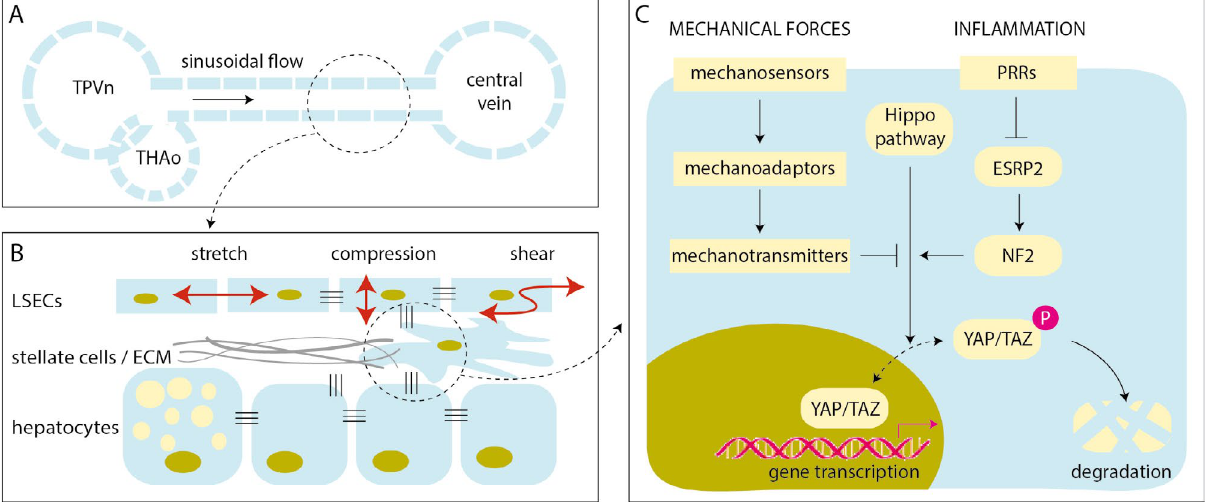
Figure 1. Mechanotransduction and the regulation of YAP/TAZ in NAFLD. A. Schematic illustration of a liver sinusoid with blood flowing from the confluence of terminal portal venule (TPVn) and terminal hepatic arteriole (THAo) toward the central vein; B. LSECs are subjected to various forms of mechanical forces by the blood flow (red arrows). LSECs may respond with endothelial dysfunction, causing defenestration and capillarization, worsening hepatocellular steatosis, activating stellate cells that may contract and produce ECM, initiating angiogenesis, microthrombosis, and elevating the portal pressure (many of these are not shown in this scheme). These events stiffen the liver and activate mechanotransduction pathways with multiple amplification loops; C. schematic diagram of the YAP/TAZ pathway in a liver cell. Mechanical forces and inflammation may act synergistically and weaken Hippo-mediated phosphorylation and degradation of YAP/TAZ, which is then translocated to the nucleus and promotes cell growth and proliferation. P: phosphate; PRR: patter recognition